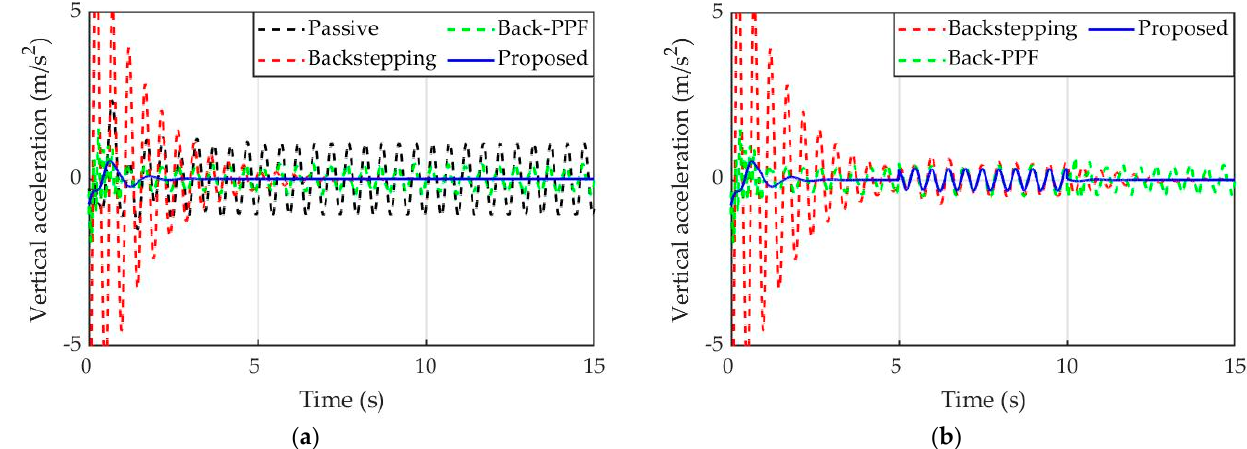
Figure 5. Sprung mass vertical acceleration: ( a ) Non-fault; ( b ) Actuator-fault.